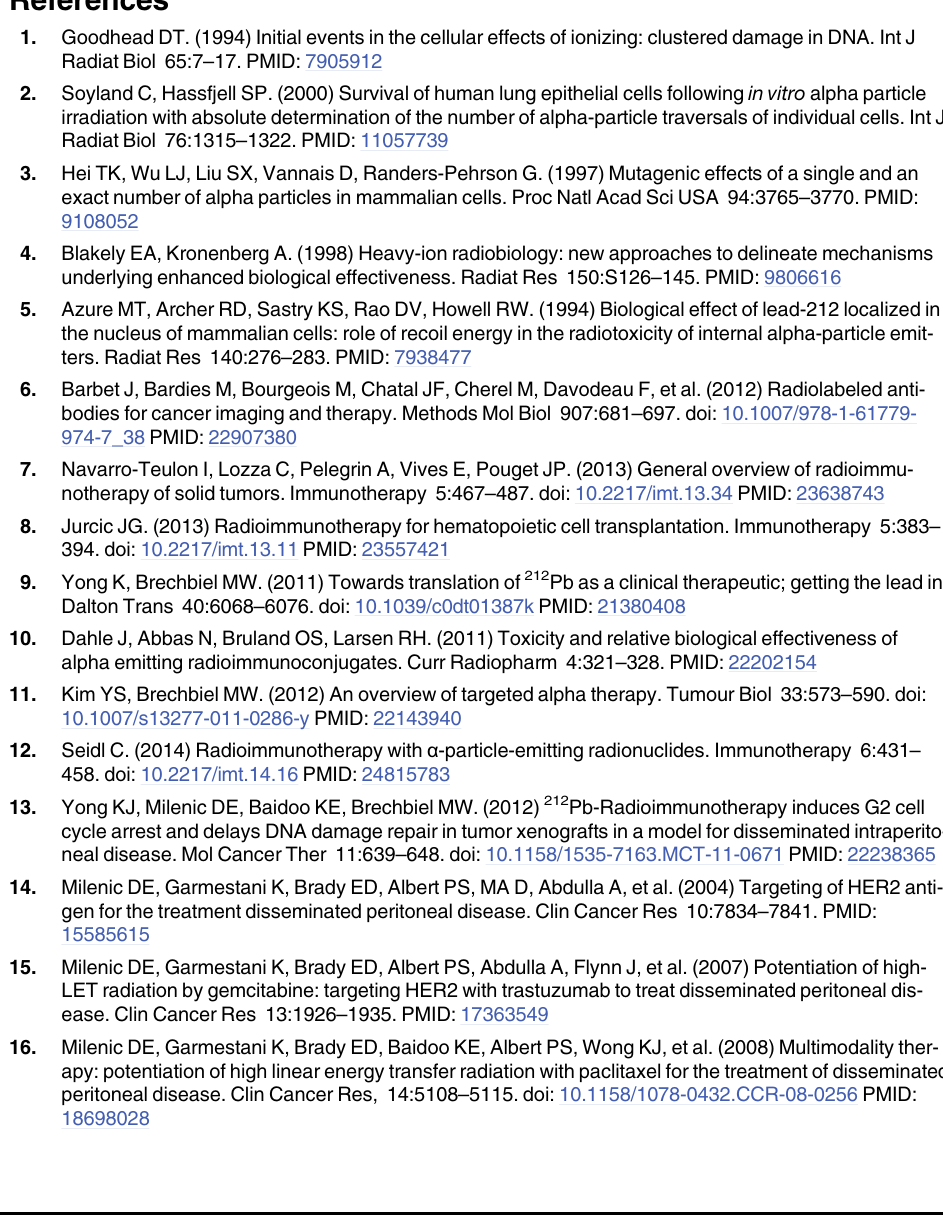
(Table 3) was characterized with the human DNA damage signaling pathway PCR array.